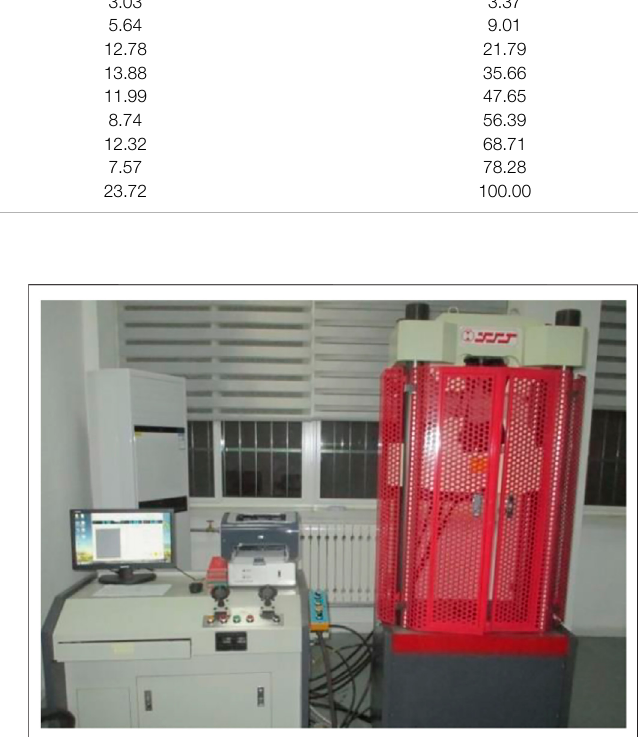
FIGURE 2 | WAW-600B electronic universal testing